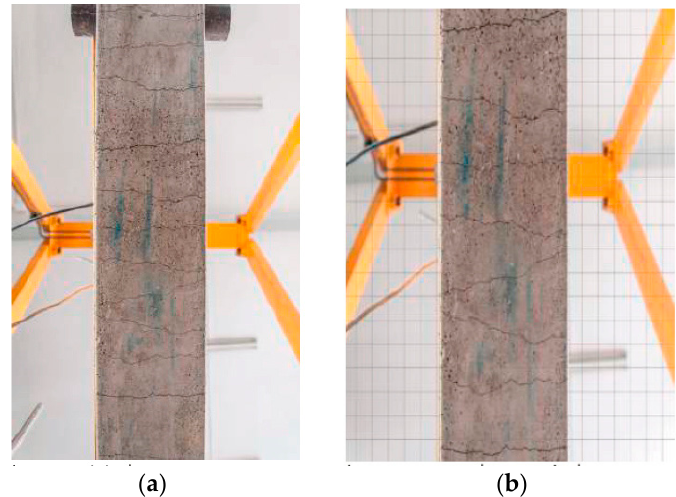
Figure 14. First enhancements: ( a ) original image; and ( b ) image without optical aberrations.